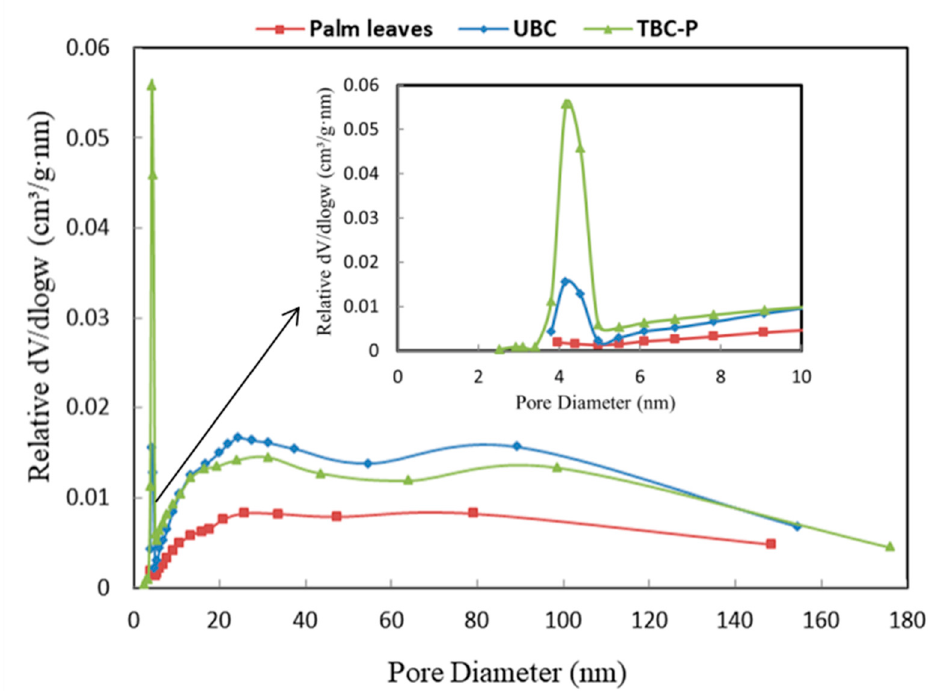
Figure 5. Pore size distribution of palm leaves, UBC and TBC-P.